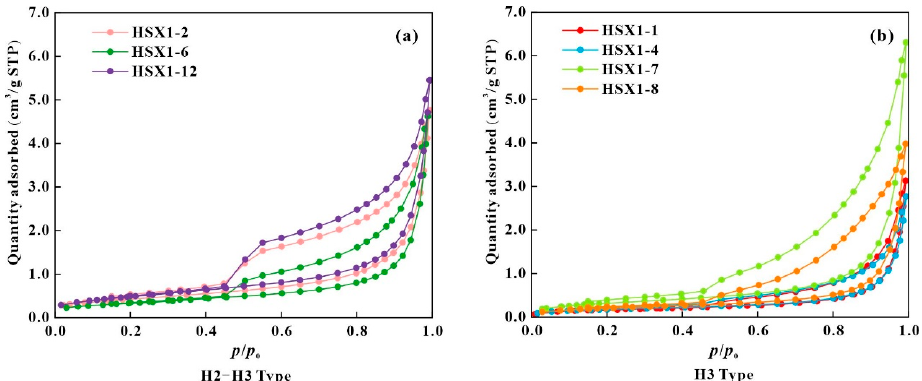
Figure 4. N 2 adsorption–desorption isotherms of shales from Fengcheng Formation: ( a ) Nitrogen